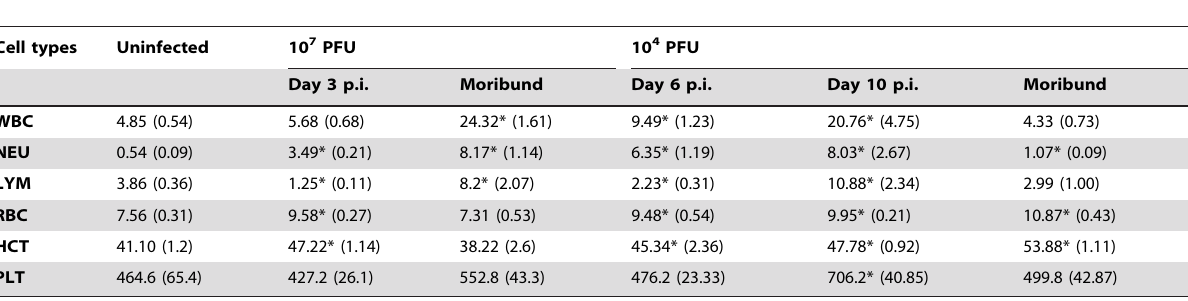
Table 1. Hematology in D2Y98P-infected